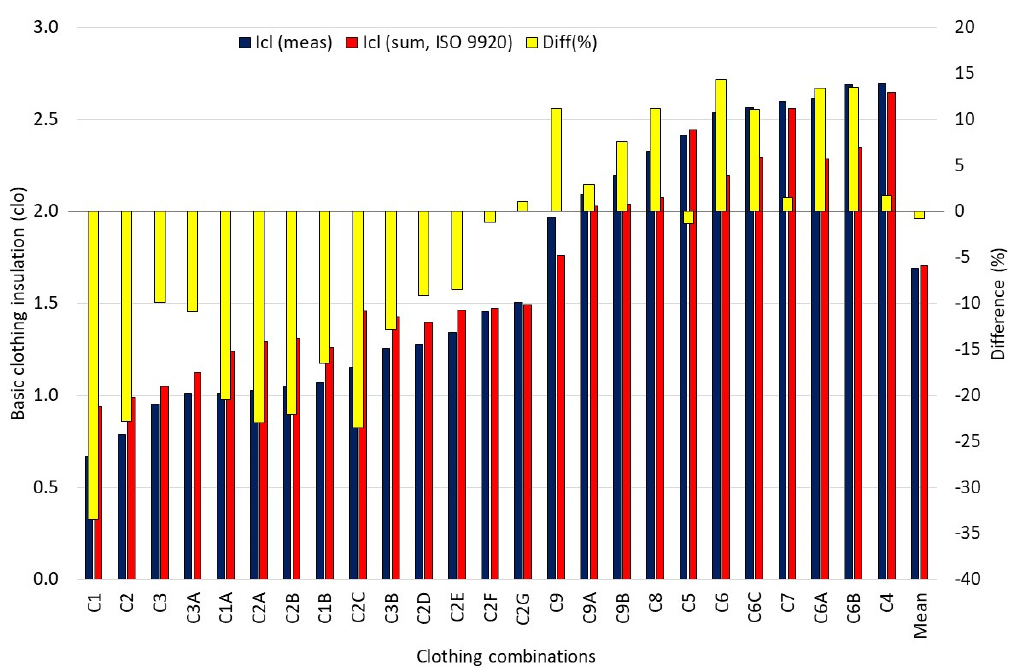
Figure A2. Measured (Icl (meas)) and summed (Icl (sum, ISO 9920)) basic clothing insulation of all ensembles ( I cl , clo) with their relative differences (Diff(%)). For clothing combination descriptions see Tables 1–3.